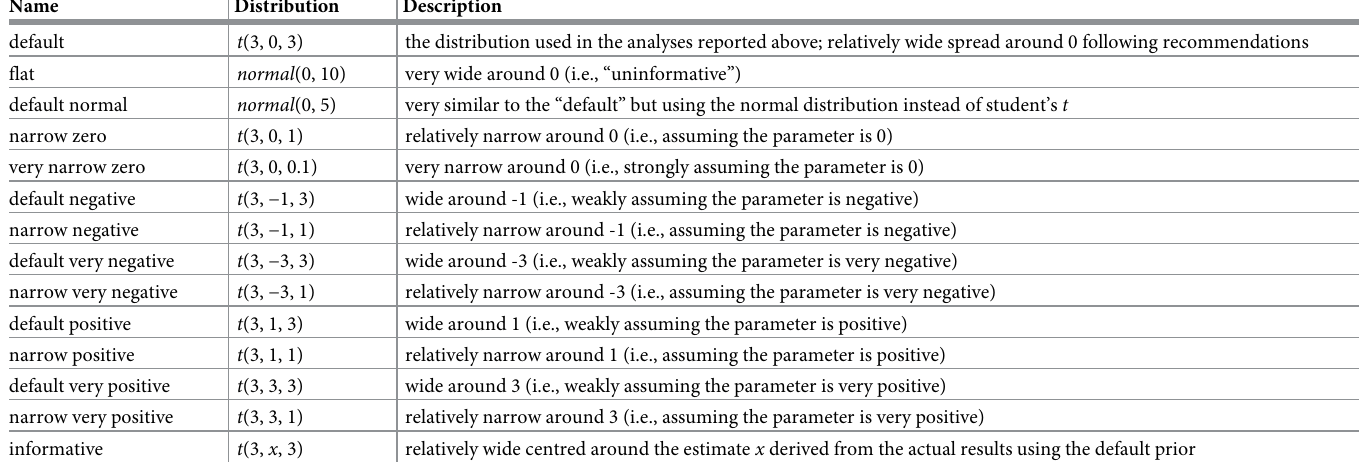
Table 15. The priors used for the sensitivity analyses of the Bayesian regressions. The student’s t ( df , μ , σ ) distribution has parameters df = degrees of freedom, μ = loca- tion (the median) and σ = scale, while the normal ( μ , σ ) has parameters μ = mean and σ = standard deviation. Remember that these distributions refer to the intercept and slope of a z -scored predictor (i.e., one with mean 0 and standard deviation 1) that is expected to have a weak and possibly negative